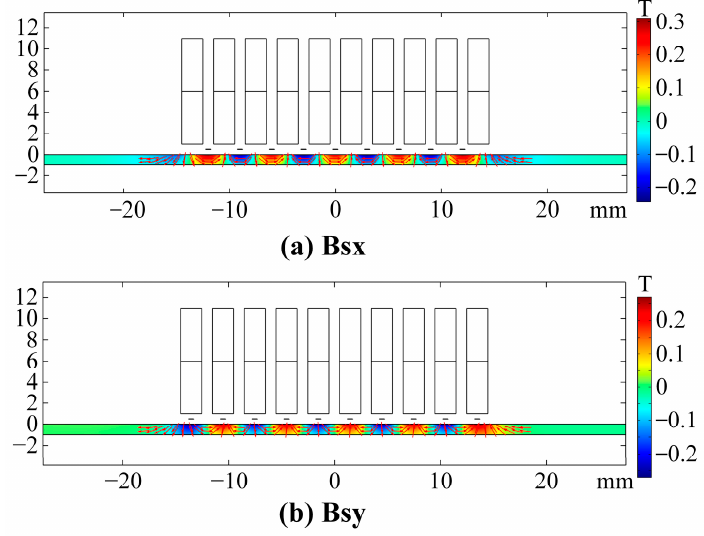
Figure 5. Distribution of the static magnetic flux density of periodic permanent magnets. ( a ) Vertical components. ( b ) Horizontal components.